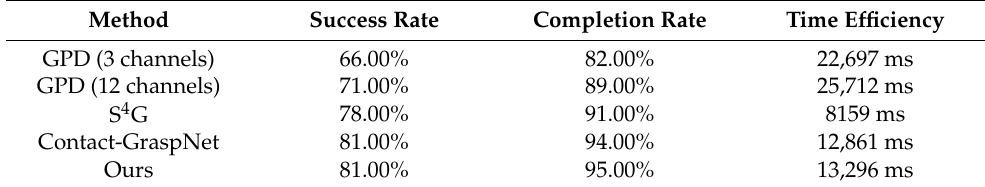
Table 6. Experimental results of multi-object